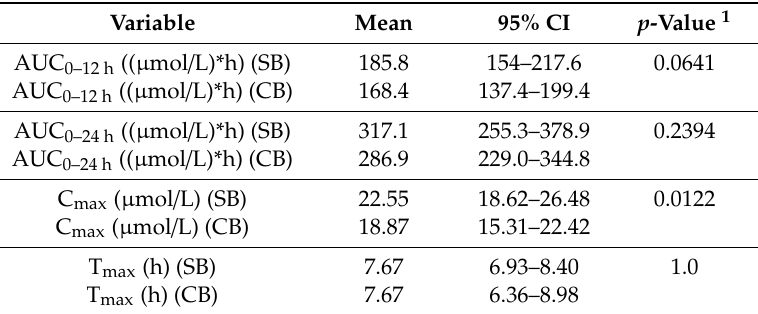
Table 3. Pharmacokinetic parameters of betaine.